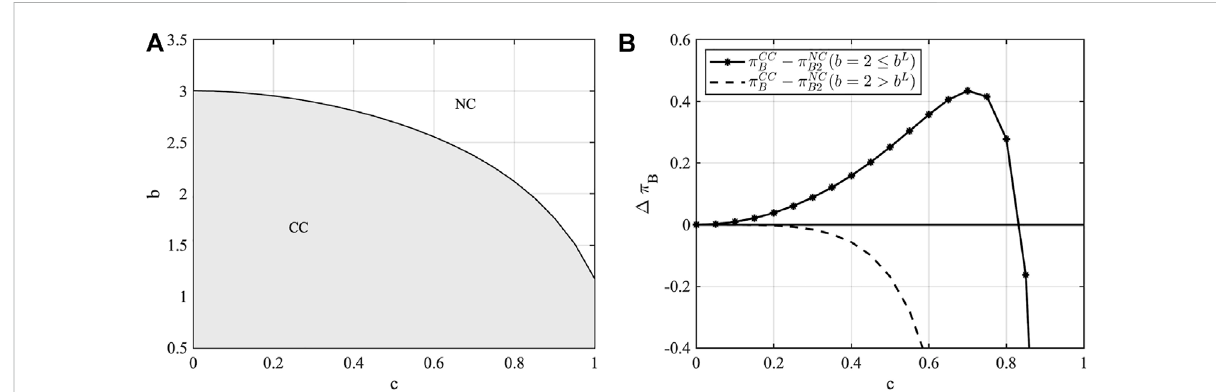
FIGURE 2 The coreenterprise ’ s strategies preference and theeffect of c on the core enterprise ’ s strategy preference. Notes. Withthe constraint satis fi ed, we set l B = 0.8; γ B = 4; l S = 0.4; γ S = 1; h = 0.75. (A) Preferred strategies of core enterprise. (B) The effect of c on core enterprise ’ s strategies